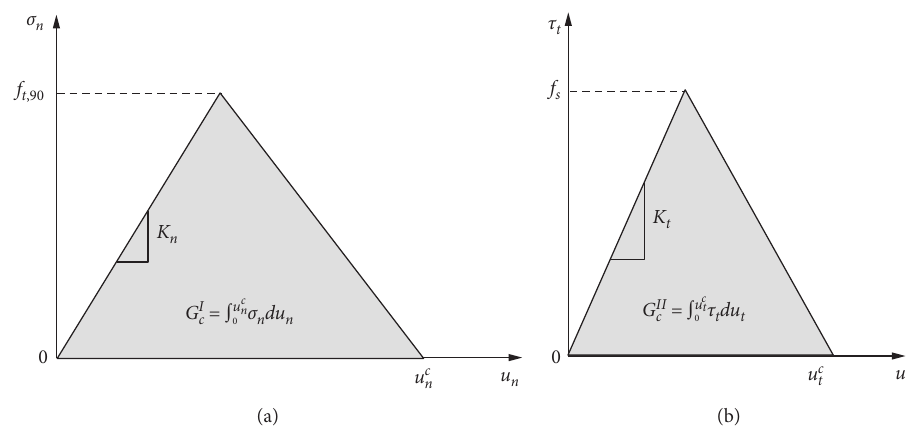
Figure 3: Cohesive zone material behavior. (a) Fracture mode I. (b) Fracture mode II.